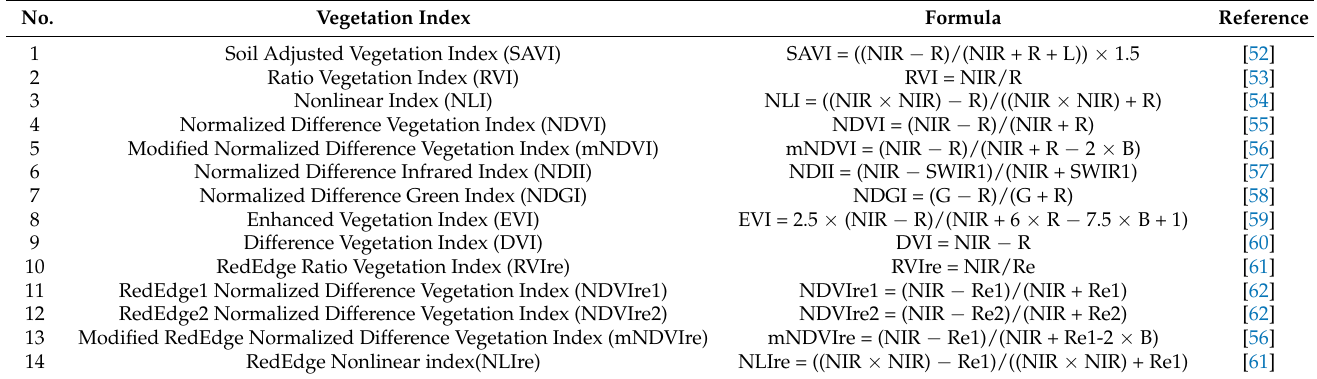
Table 2. Vegetation index formulas.